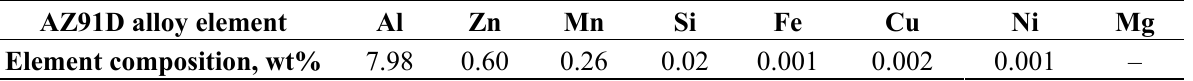
Table 1. Chemical composition of the AZ91D alloy measured by ICP-AES. AZ91D alloy